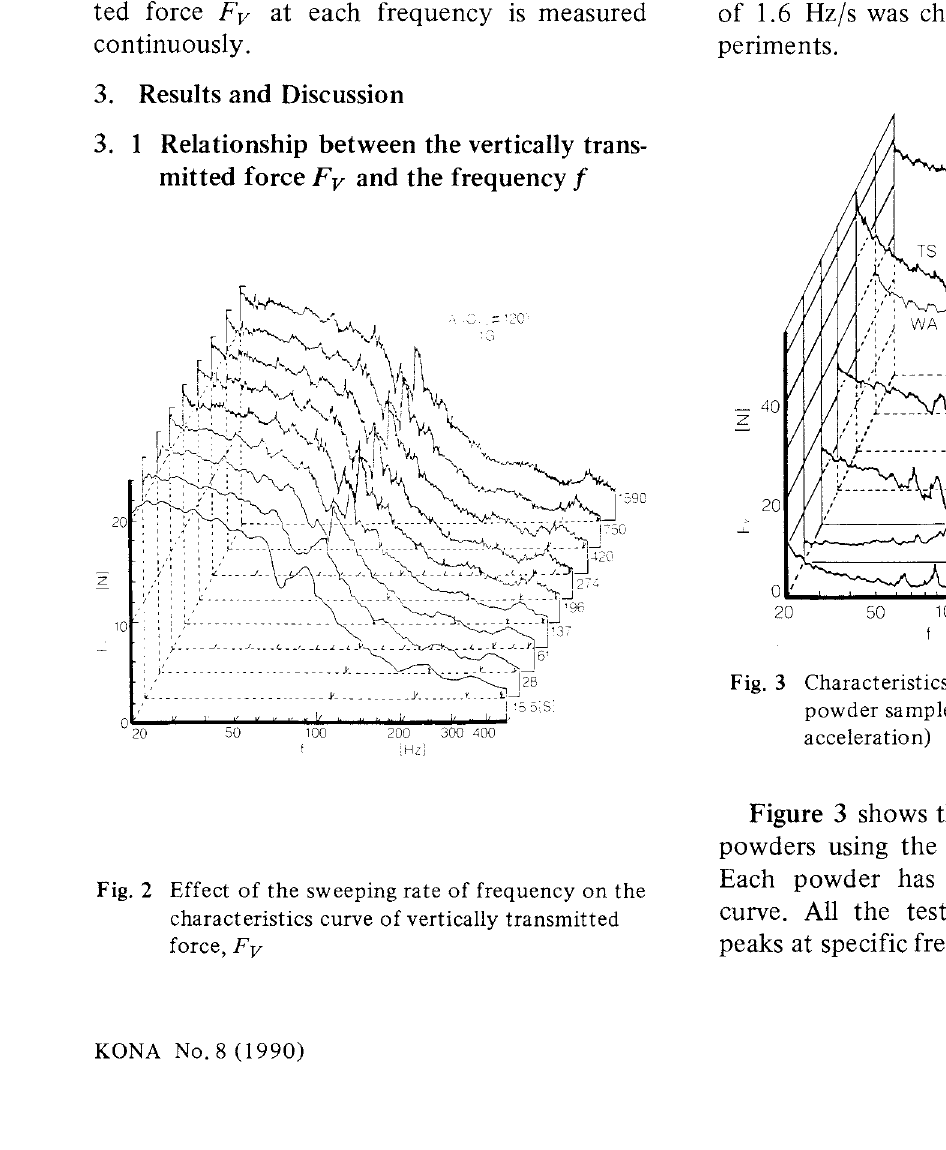
Fig. 2 Effect of the sweeping rate of frequency on the characteristics curve of vertically transmitted force, Fv